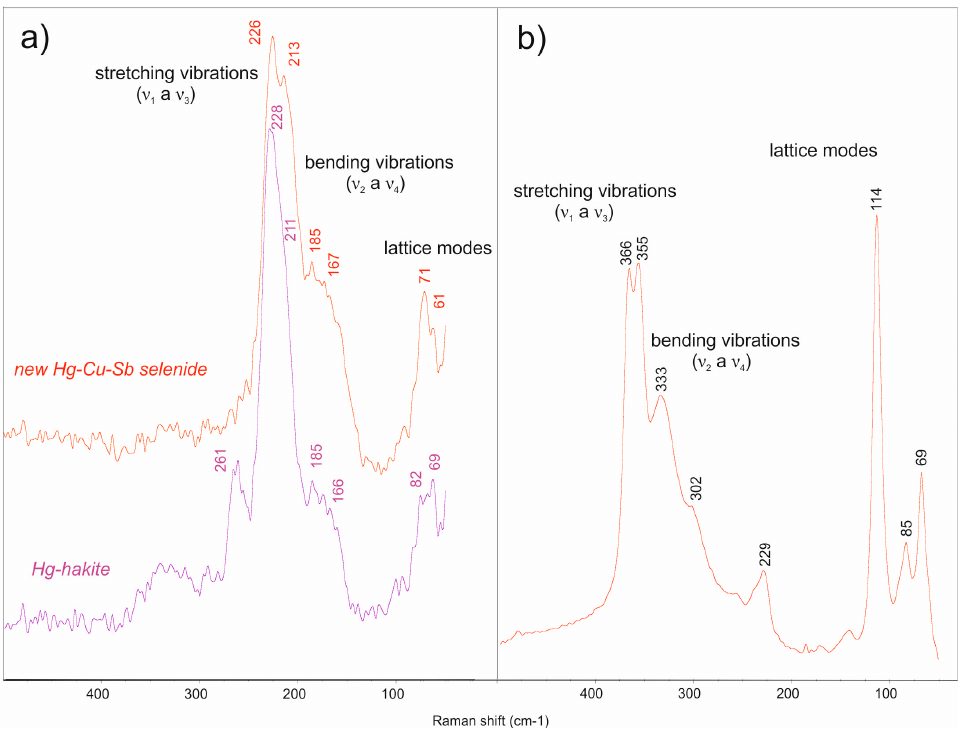
Figure 63. EBSD images of ( A ) new Hg-Cu-Sb selenide, ( B ) Hg-hakite, and ( C ) tetrahedrite from Pˇr í bram with indexed Kikuchi bands. These photos were taken from the zonal aggregate depicted in Figure 62. Photo by M. Racek. Minerals 2017 , 7 , 91